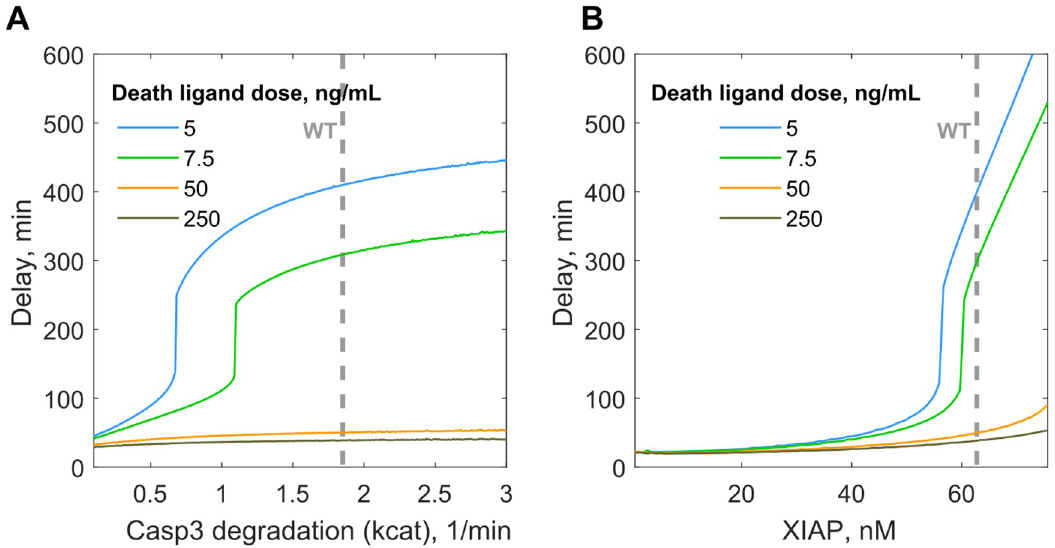
Fig 4. Cell death delay sensitivity to the change in ProCasp6 concentration and Casp3 degradation kinetics in the clustering scenario. (A) Dramatic increase in the cell death delay upon the increased Casp3 degradation rate constant (kcat) by XIAP mediated ubiquitination which is a function of proteasomal protein degradation capacity as well as Casp3 self-cleavage for the cells stimulated with lower DL doses (5, 7.5 ng/mL). (B) High sensitivity to the minor decrease in XIAP concentration from its mean estimated concentration in HeLa cell 63 nM will lead to dramatic decrease in cell death delay for the cells stimulated with lower DL doses.